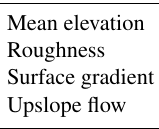
Table B6. Variables from the ASTER DEM adopted in this